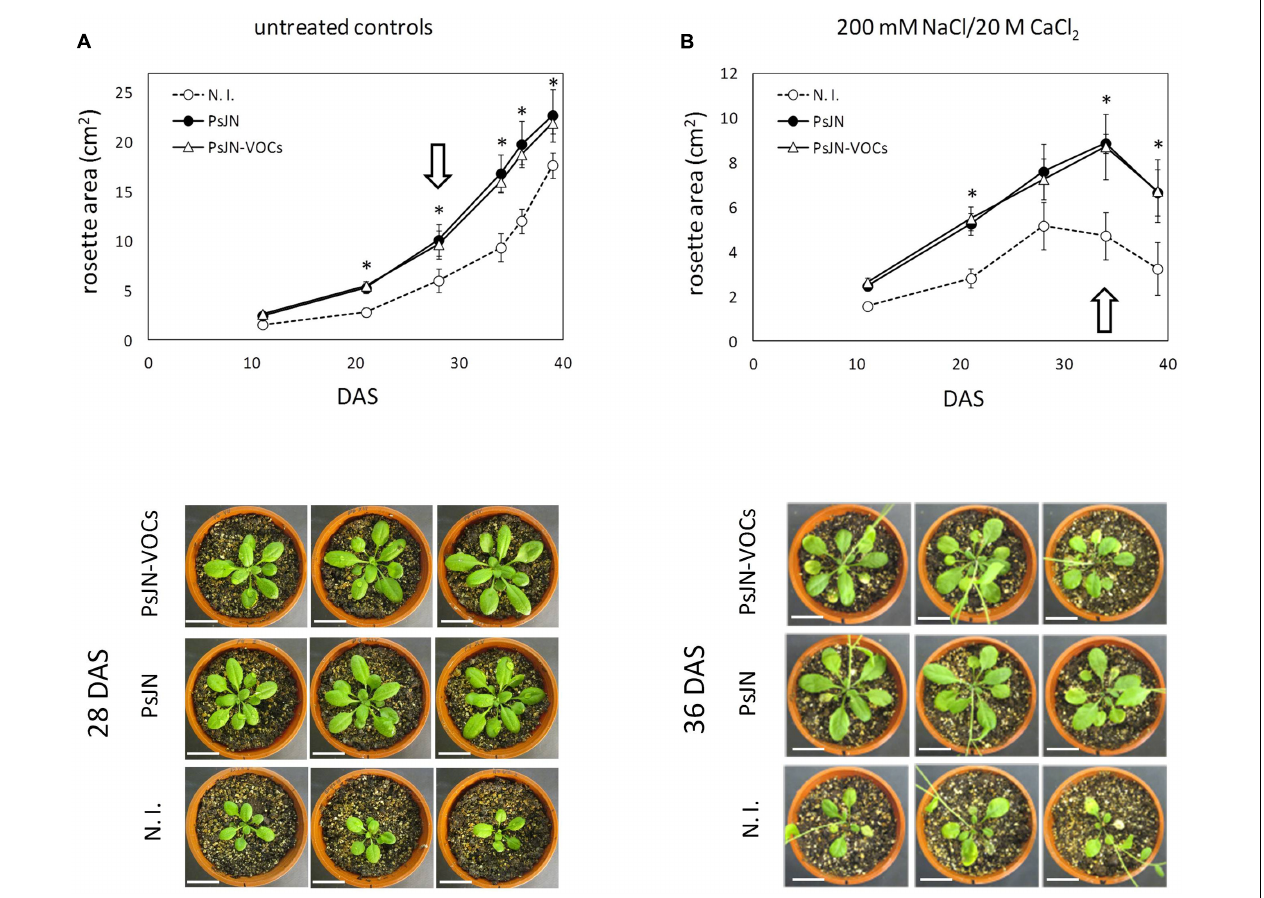
FIGURE 3 | Long-term effects of exposure to volatile emission from P. phytofirmans. Arabidopsis seeds were exposed to PsJN volatiles (PsJN-VOCs), directly inoculated with the bacterium (PsJN), or non-inoculated (N. I.) in the dual plate system for 11 DAS, and plantlets were transferred to soil. Transferred plants were irrigated three times a week. Untreated controls received only standard irrigation water (A) , while treated plants received 2 irrigations with standard water and a third containing 200 mM of NaCl and 20 mM of CaCl 2 (B) . Images of 10 representative plants taken at different times, and rosette area was measured for each treatment. Asterisks indicate statistically significant differences among PsJN and N. I: plants within each measured time point, which were explored using One-Way ANOVA Tukey’s HSD tests; p < 0.05. Images of representative plants are shown below each treatment, representing time points (DAS) with the highest differences in rosette area for untreated controls and salt irrigated plants (highlighted by white